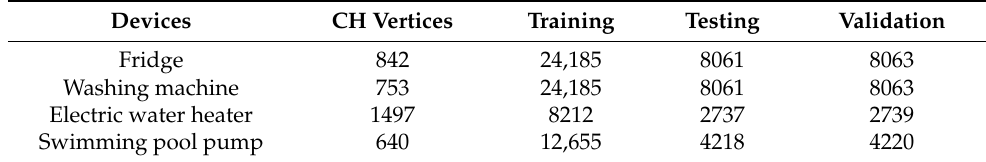
Table 3. Approxhull results for